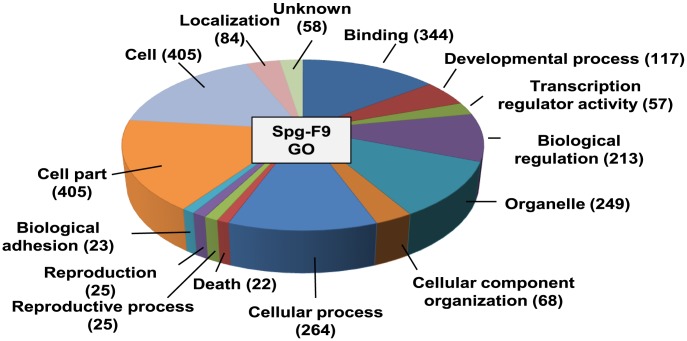
Enriched gene ontology (GO) terms in the spermatogonia-F9 group.A total of 487 genes in the Spg-F9 group were analyzed for the enrichment of GO terms using the DAVID functional annotation chart. Only significant GO terms are shown (p-value<0.05). The pie slices are proportional to the number of genes.